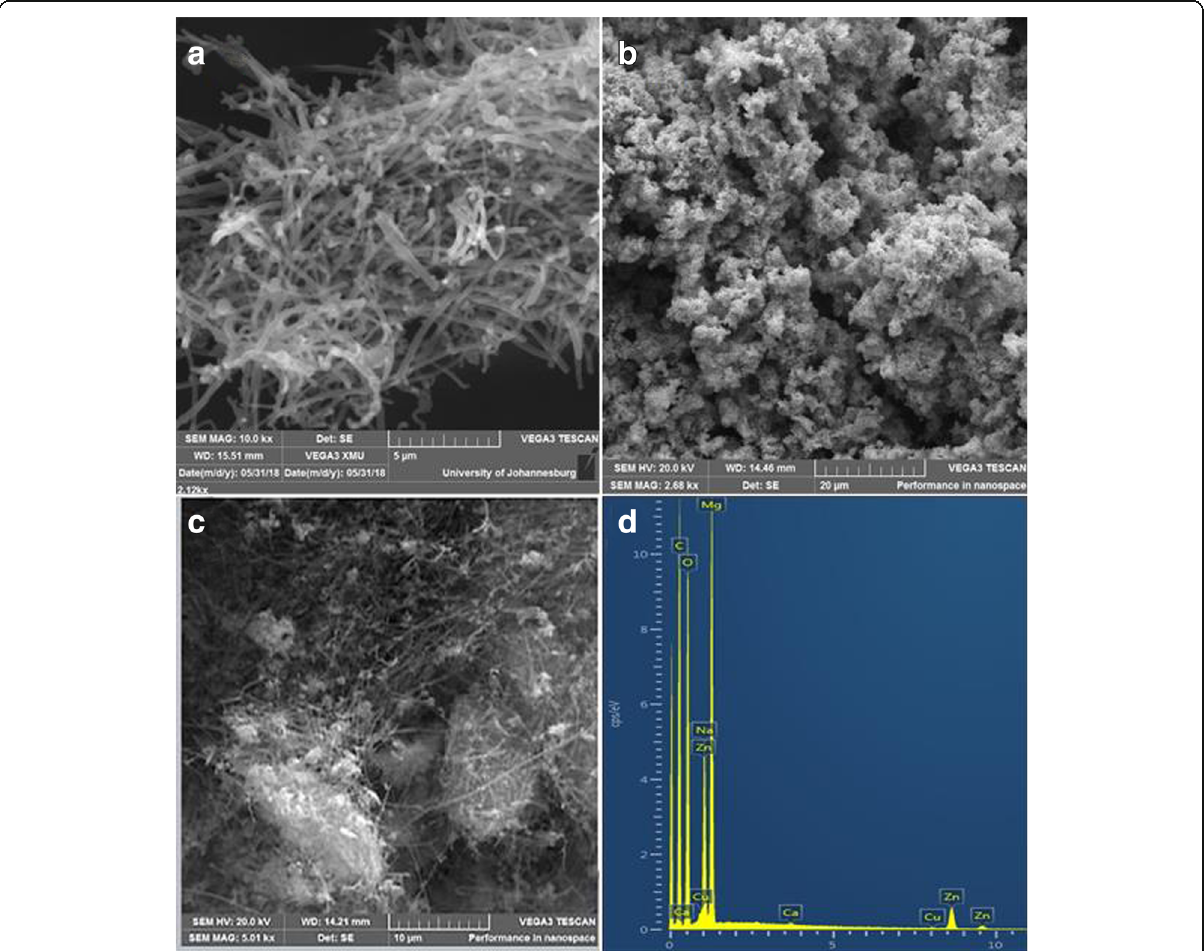
Fig. 4 SEM images of a CNFs, b MgO-ZnO, c MgO-ZnO@CNFs, and d EDX of MgO-ZnO@CNFs